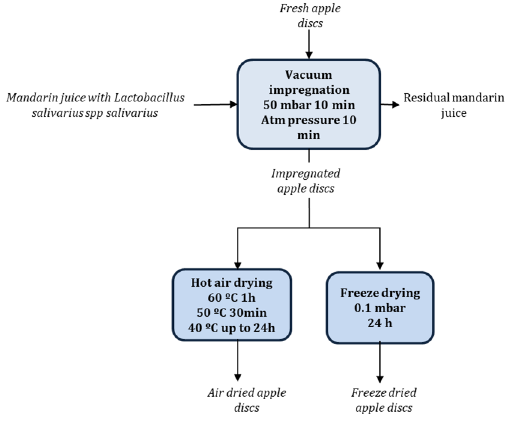
Figure 1. Schematic process to obtain impregnated and dried apple discs with probiotic microorganisms.